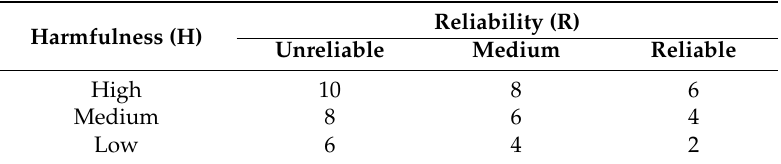
Table 1. Pollution hazard ranking matrix for mine tailings pond